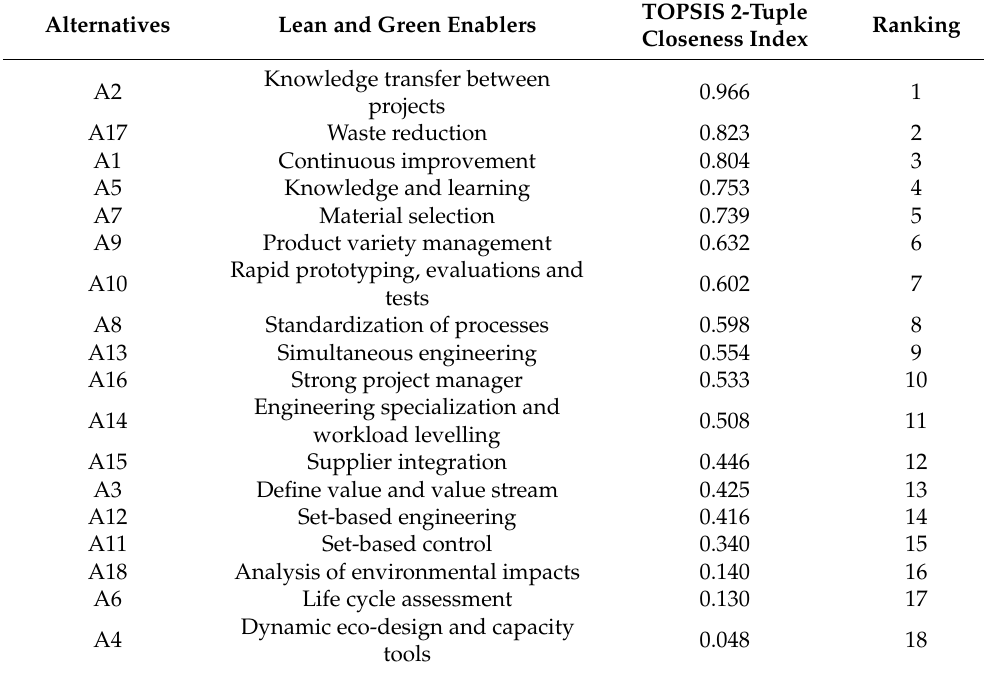
Table 9. TOPSIS 2-tuple closeness index from Brazilian